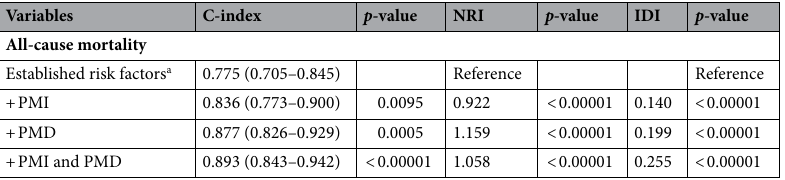
Table 4. Predictive accuracy of the psoas muscle index and psoas muscle density for all-cause mortality. NRI net reclassification improvement, IDI integrated discrimination improvement, PMI psoas muscle index, PMD psoas muscle density. a Gender and age, history of cardiovascular disease, geriatric nutritional risk index, simplified creatinine index, and log of C-reactive protein